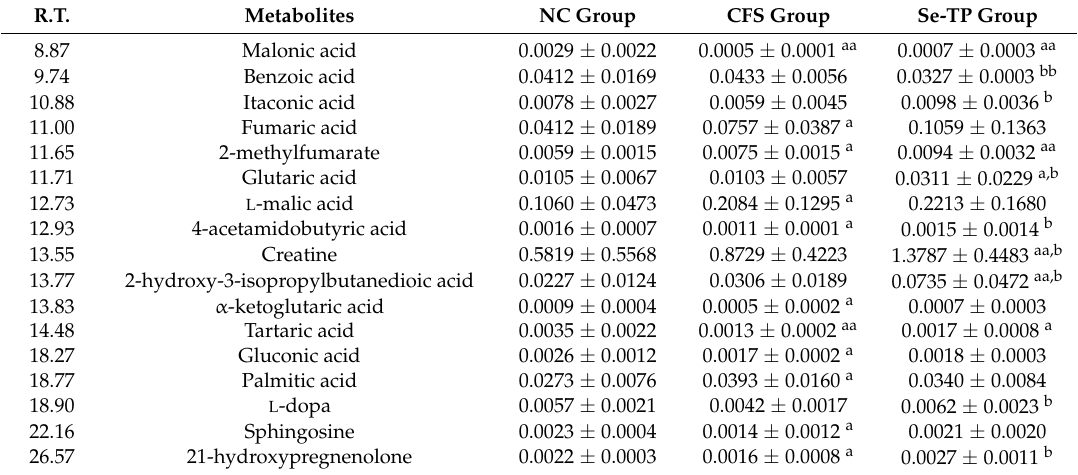
Table 4. The peak area relative value of the differential